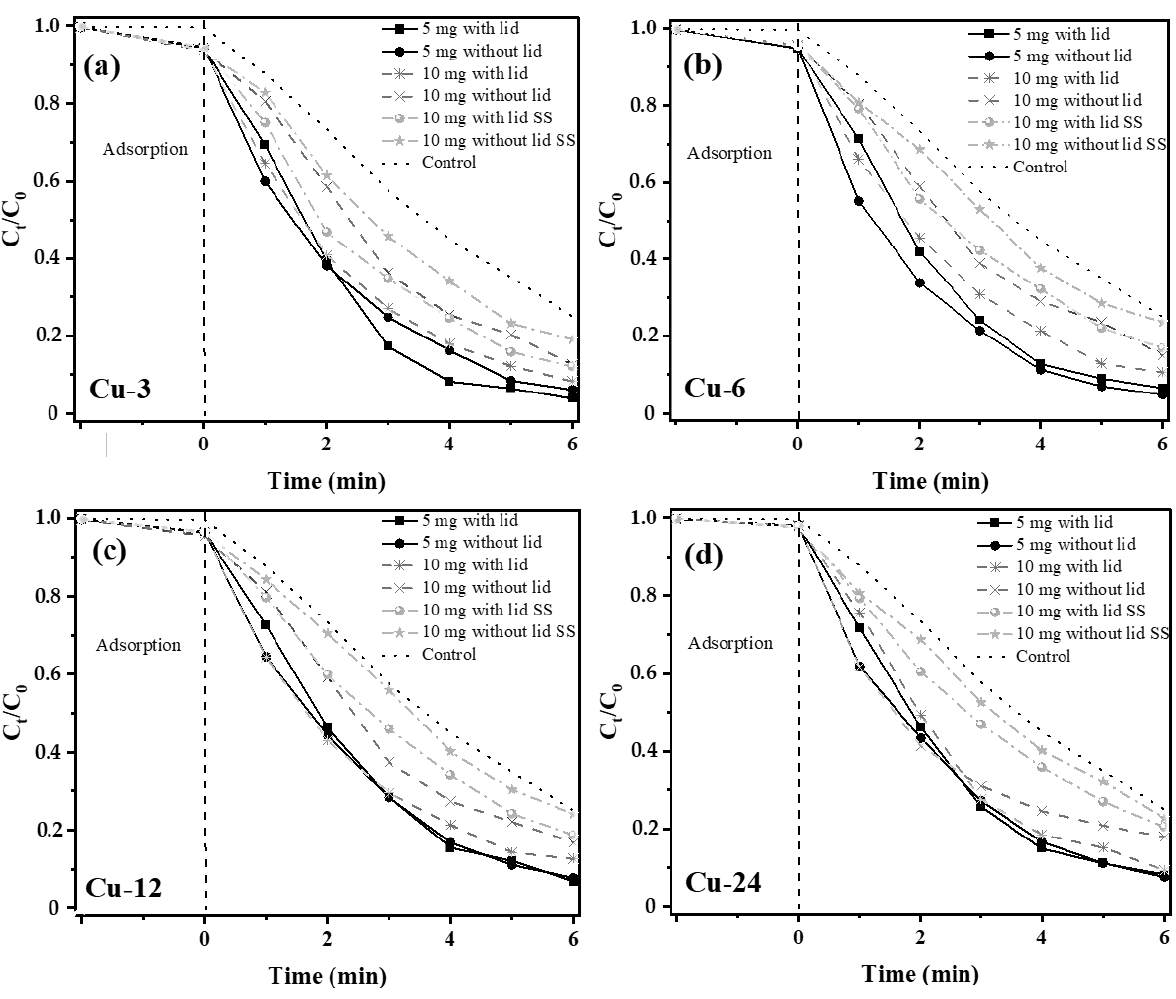
Figure 7. Normalized MB degradation curves under sunlight radiation with ( a ) Cu-3, ( b ) Cu-6, ( c ) Cu-12 and ( d ) Cu-24 in 20 mL aqueous solution with an MB concentration of 5 mg/L. The photocatalytic degradation efficiency depends on the active surface area of the photocatalyst. For higher amounts of catalysts, i.e., 10 mg, the dye-degradation efficiency decreases to 87%, 85%, 83% and 82% for the Cu-3, Cu-6, Cu-12 and Cu-24 samples, respec- tively, at the end of 6 h. It has been reported that the photocatalytic degradation efficiency increases as the amount of photocatalyst increases up to an optimum quantity of catalyst, after which a decrease in degradation is observed [59]. In this particular study, the nano- composites are hydrophobic and remain on the surface of the aqueous solution. For 5 mg of catalyst, a thin layer of nanoparticles is formed on the surface of the liquid, which thick- ens with an increase in the catalyst amount, making the surface opaque. Additionally, only the topmost layers in the catalyst surface are exposed to sunlight, which may not be in contact with the aqueous solution. This implies that the charge transfer from the nano- particles to the organic pollutants in the aqueous solution may be less efficient. This shielding effect due to the increase in the quantity of the photocatalyst could explain the lower photocatalytic activity. In addition, at high concentrations, the photocatalyst nano- particles have a tendency to aggregate, which, in turn, reduces the number of active sites. Khataee et al. reported similar results, in which degradation efficiency increases from 14% to 57% with a catalyst dosage from 0.25 to 1 g/L, followed by a decrease in the degradation efficiency by 50% with a further increase in the catalyst dosage up to 2 g/L [60]. In fact, for